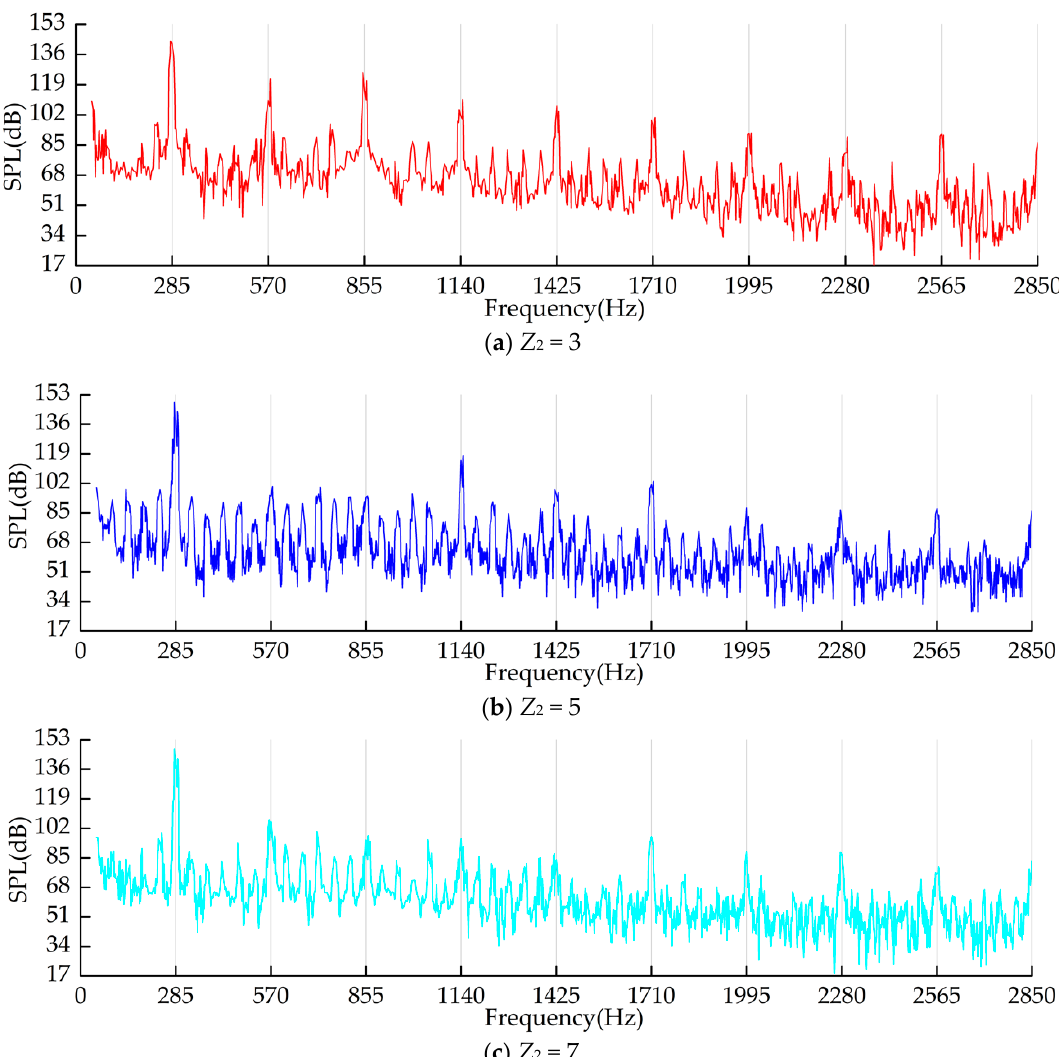
Figure 12. Frequency response curves of the hydroacoustic SPL inside the impeller with different numbers of guide vanes.